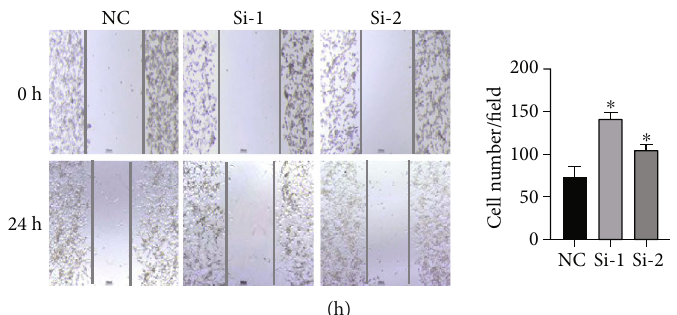
Figure 6: MEX3A promotes proliferation, migration, and invasion of ES2 cells in vitro. (a) Relative mRNA level of MEX3A in ovarian cancer cell lines. (b, c) The mRNA and protein expression of MEX3A in MEX3A knockdown ES2 cell treated with shRNA. (d, f) The CCK-8 assay, colony formation assay, and EdU assay showed that MEX3A knockdown in ES2 cells could suppress proliferative capability. (g, h) Migration and wound healing assay were utilized to evaluate and identify metastasis ability after MEX3A knockdown in ES2 cells. The data are presented as the mean ± SD ( n = 3 ). ∗ P < 0 : 05 , ∗∗ P < 0 : 01 , and ∗∗∗ P < 0 : 001